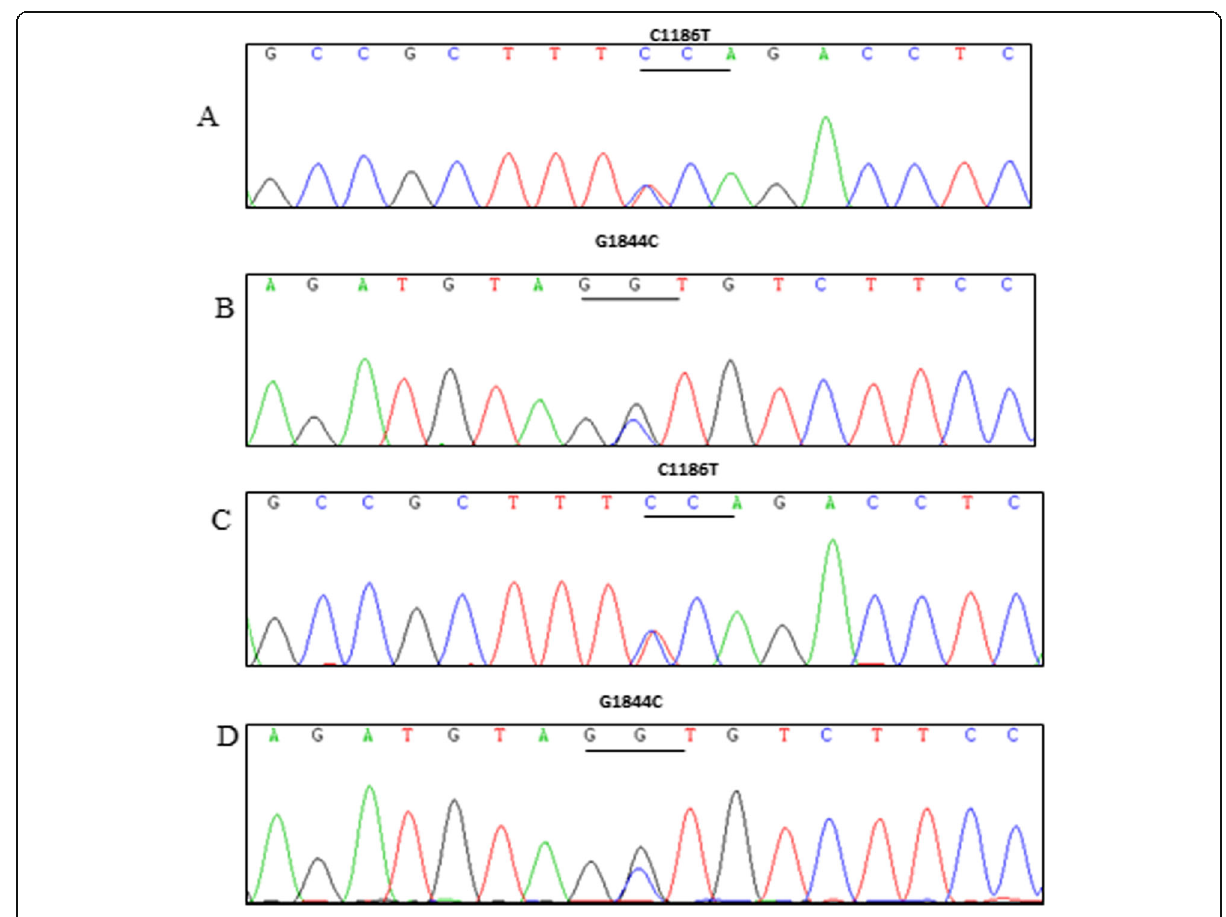
Fig. 3 Sequence chromatograms of this Chinese family. ( a ) TWNK c.1186C> T (p.Pro396Ser) from the proband ( b ) TWNK c.1844G > C (p.Gly615Ala) from the proband ( c ) TWNK c.1186C > T (p.Pro396Ser) from the father ( d ) TWNK c.1844G > C (p.Gly615Ala) from the